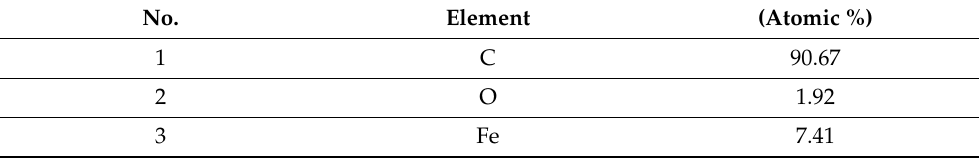
Figure 1. SEM ( A – C ) images and EDX ( D ) spectrum of multi-walled carbon nanotubes collected from the reactor. Table 1. Element composition of the pristine MWCNTs from the EDX